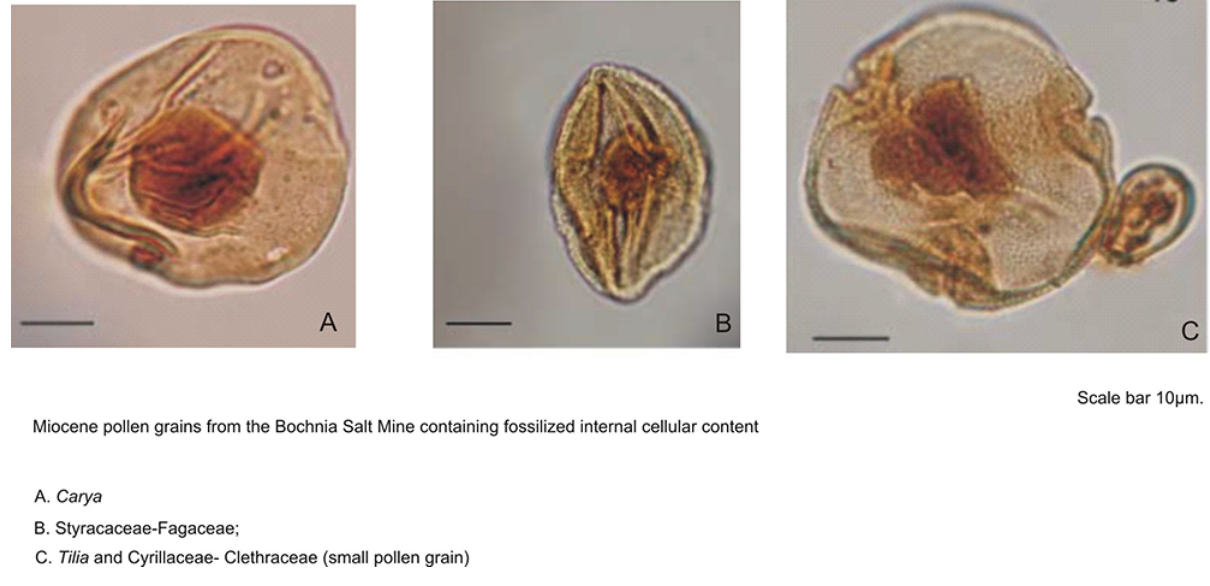
Figure 6 Miocene pollen grains from the Bochnia Salt Mine containing fossilized internal cellular contents. Photo: E. Durska.